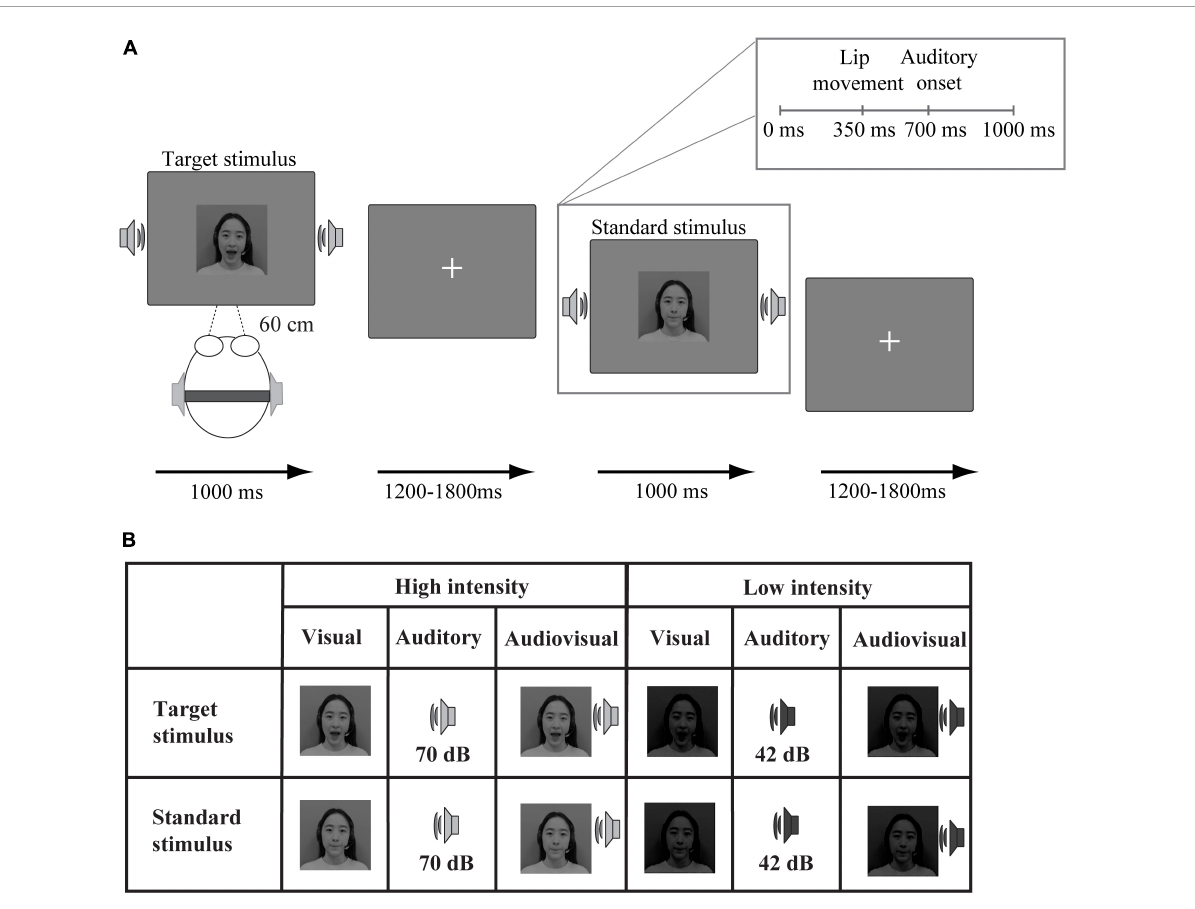
FIGURE1 Schematic illustration of the experimental procedure. (A) An example of an audiovisual target stimulus and an audiovisual standard stimulus. (B) Twelve stimulus types were presented: target (“ga”) and standard (“ba”) stimuli presented in visual, auditory, and audiovisual modalities under high-intensity and low-intensity